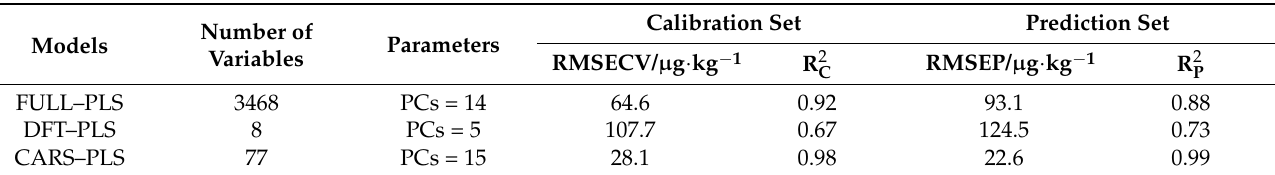
Table 3. Prediction results of different PLS